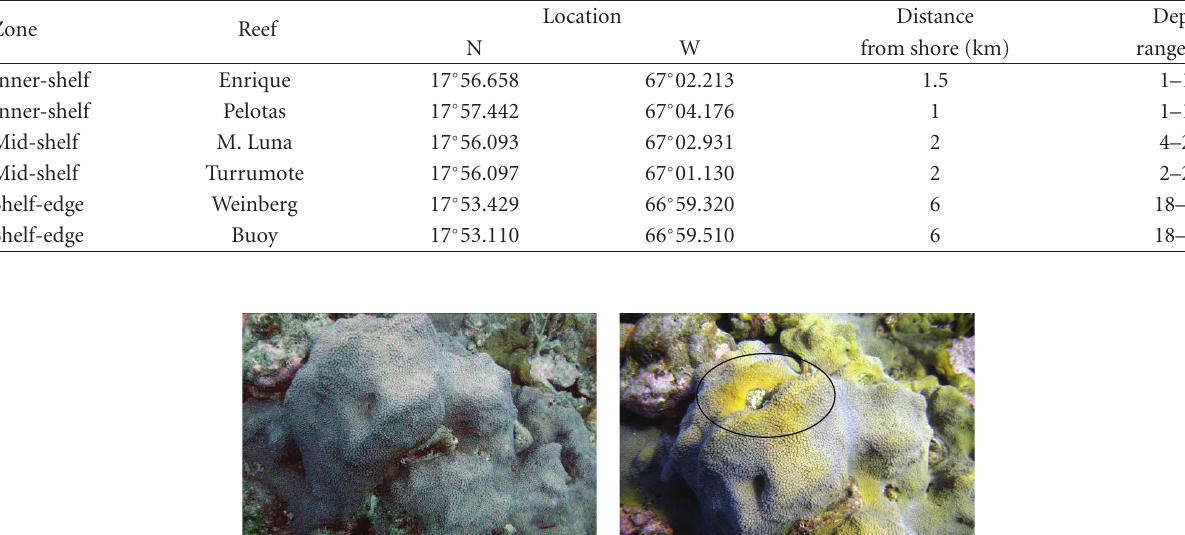
Table 1: Characteristics of the study sites in La Parguera, Puerto Rico (modified from [27]).